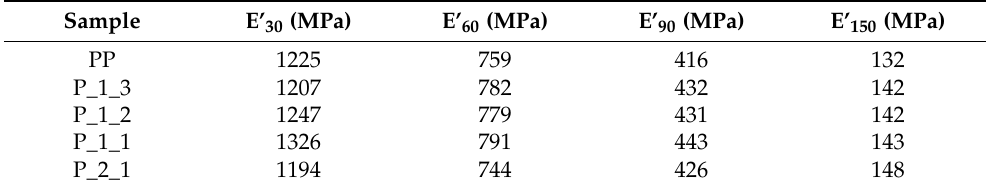
Table 2. Results of dynamic mechanical analysis (DMA) tests of individual samples.